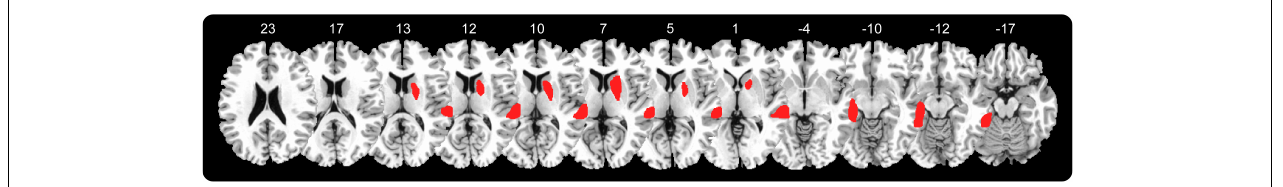
FIGURE 2 | Patient lesion mapping, right hemisphere lesion involving: superior and middle temporal gyrus, basal ganglia (caudate nucleus, putamen, and pallidum), anterior limb of the internal capsule, anterior corona radiate, and external capsule.